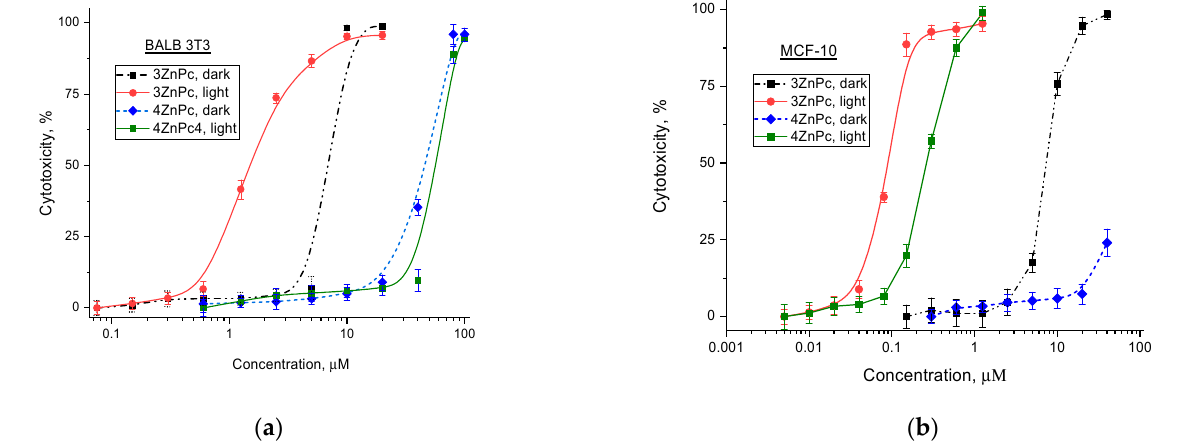
Figure 2. Dark and photo-cytotoxicity of zinc(II) phthalocyanines with non-peripheral groups for 3ZnPc and peripheral groups for 4ZnPc studied on two normal cell lines: ( a ) normal BALB 3T3 cell line and ( b ) non-tumorigenic MCF-10A cell line.